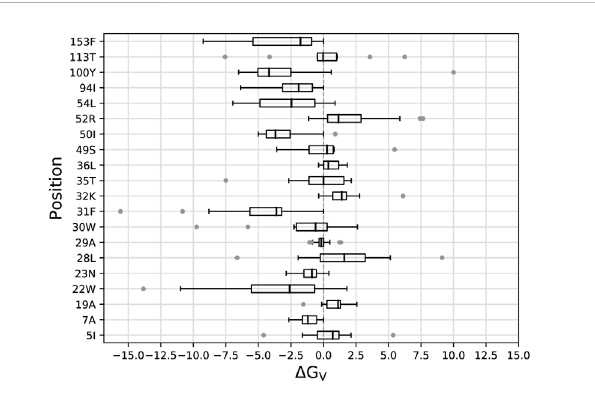
FIGURE 2 Boxplotsofvitalities(kcal/mol)fromsingletonredesignof20DHFR positions. Each box encloses half the data; the thick line is the median. Gray points are outliers more than 1.5 times the width of the second or third quartile. Whiskers are delimited, on each side, by the last point that is not an